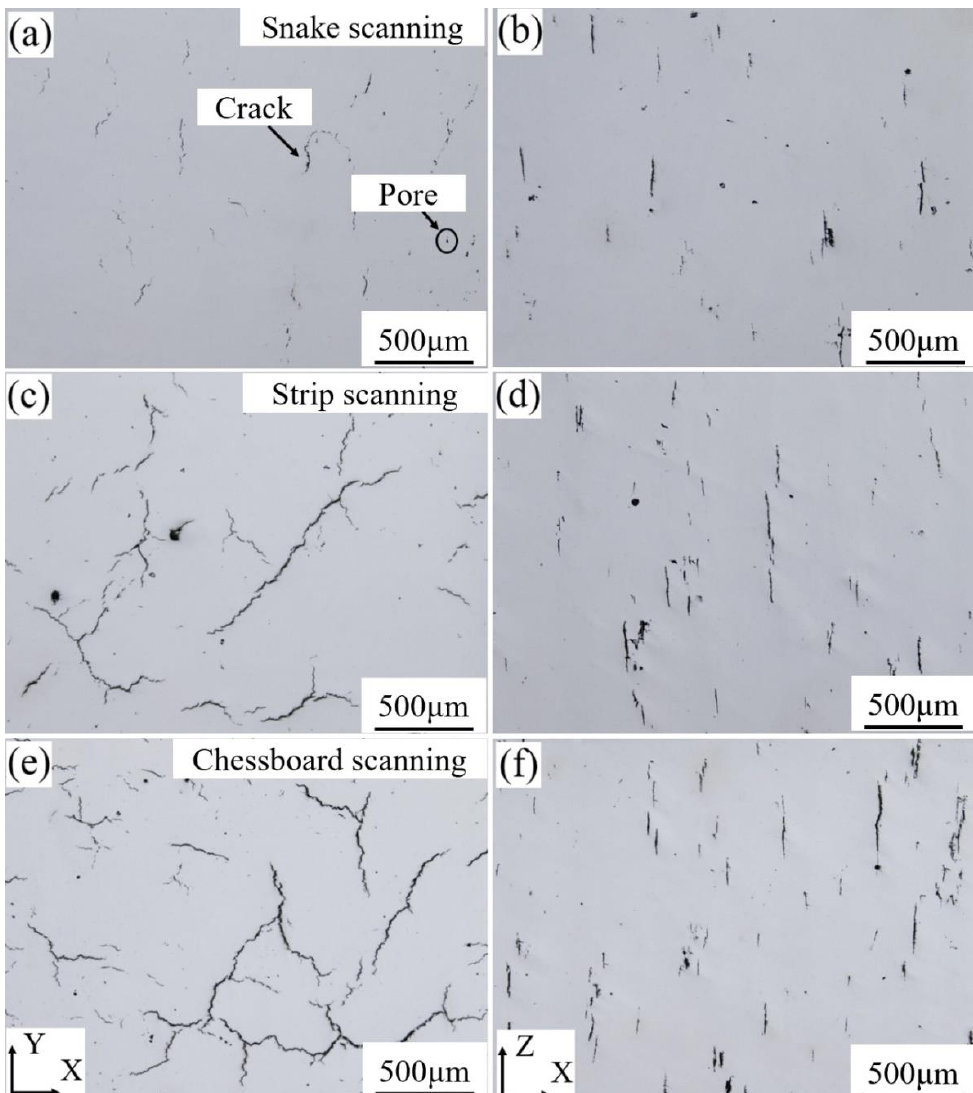
Figure 3. Cracks in the cross-section of the X–Y and X–Z planes of René 104 superalloy samples fabricated by SLM using different scanning strategies; ( a , b ) snake scanning; ( c , d ) stripe partition scanning; ( e , f ) chessboard partition scanning.